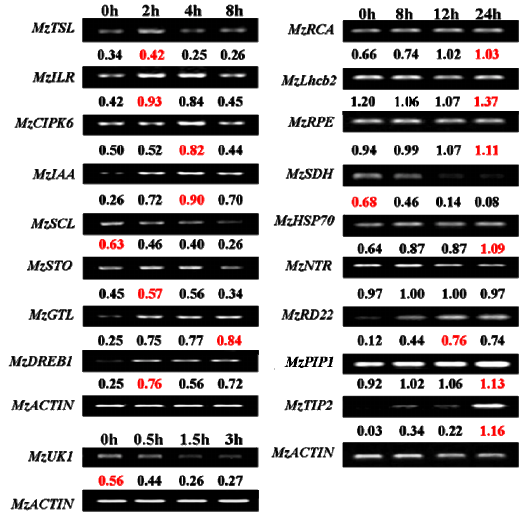
Figure 2. The validation of the expression of 18 selected salt-responsive genes under salt stress by semi-quantitative RT-PCR. The expression levels of tested genes were normalized according to the corresponding actin amplifications, and were presented under the bands. The peak of expression level was colored with red. Except for MzNTR , MzDREB , MzCIPK , and MzGTL , the RT-PCR results of 14 tested genes (nearly 78%) had a good correlation with the microarray